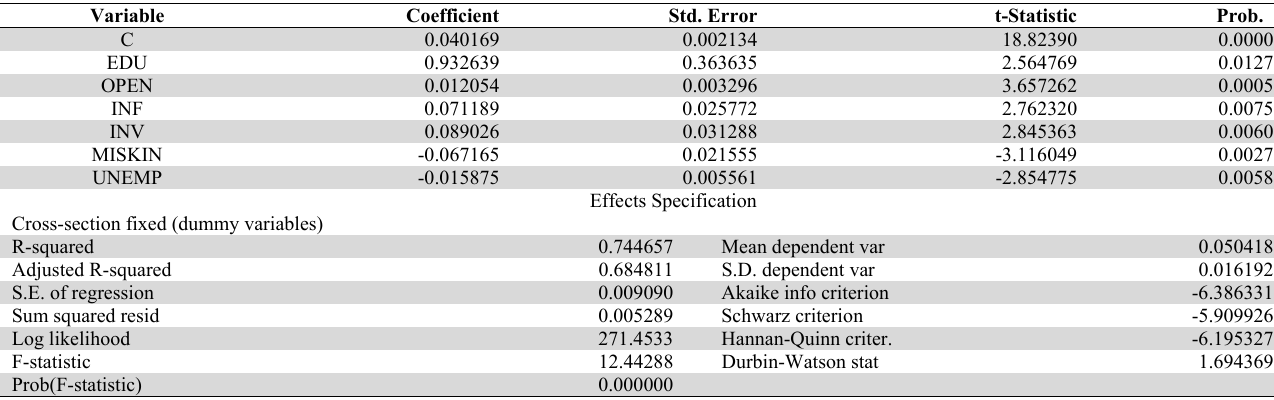
Fixed Effect Model